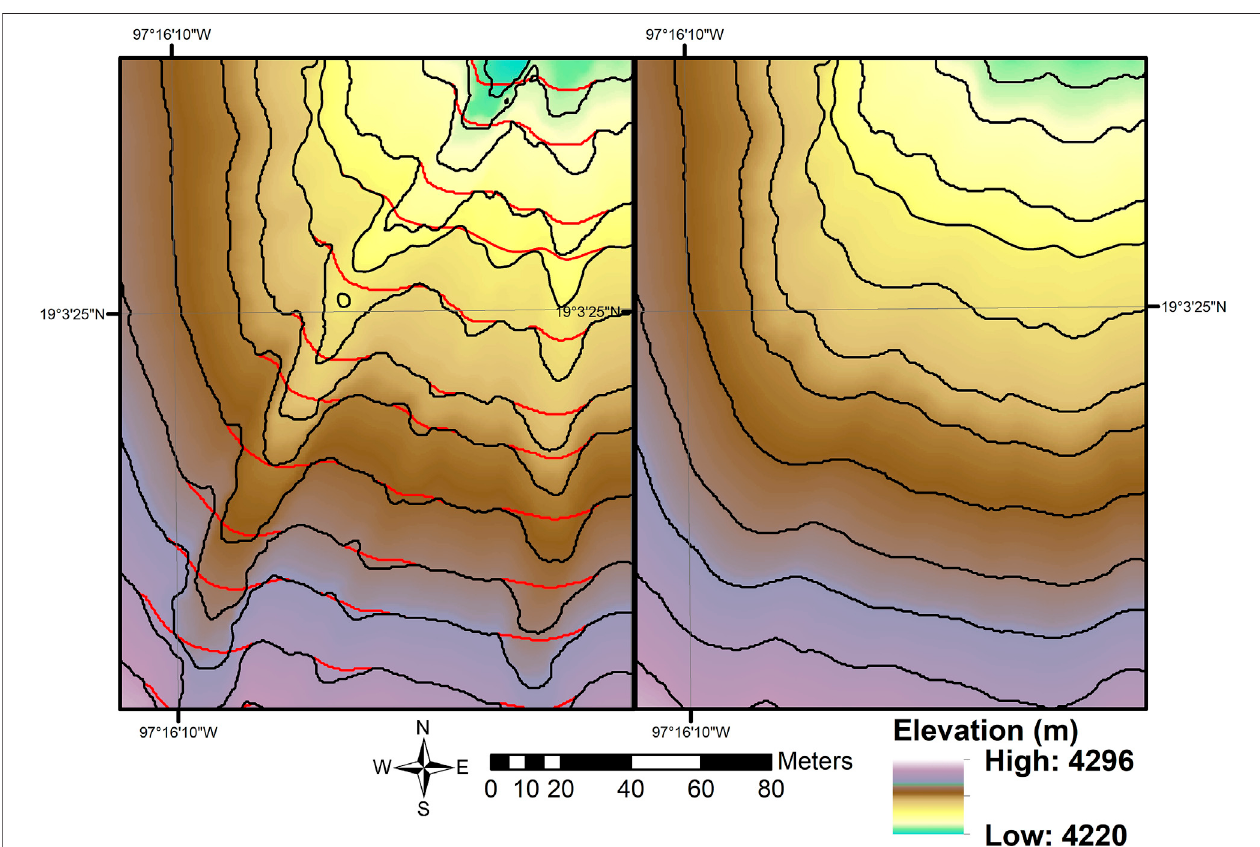
FIGURE 9 | Illustrative example of contours overlaying DEMs to re fl ect pre-Ernesto channel topography (B) from post-Ernesto channel topography (A) . The red contours, only channel contours shown, illustrate how contours were edited to recreate the pre-Ernesto topography in the mid-section of the proglacial ramp. Contour interval is 2